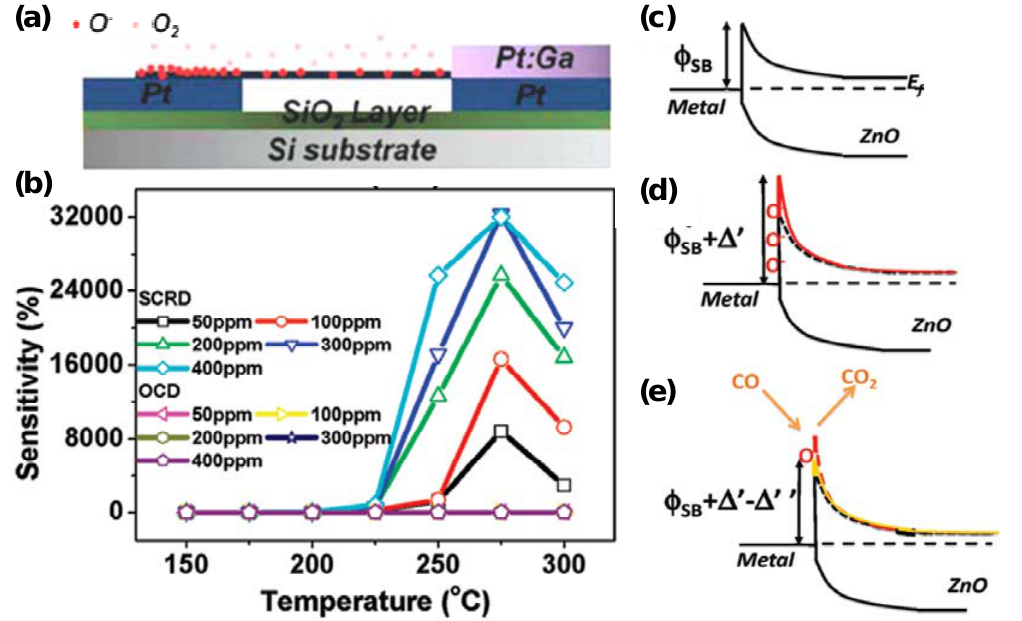
Figure 2. (a) A schematic of the SCD based on a single ZnO nanowire at O (b) Sensitivity versus system temperature for CO sensing at a response time of 1 h as a function of the CO concentration at 275 °C. Results collected from the OCD and SCD at reverse bias (SCRD) are compared. (c-e) Schematics showing the response of Schottky barrier height in response to variations in (c) N (Reprinted from reference [10] with permission from American Chemical